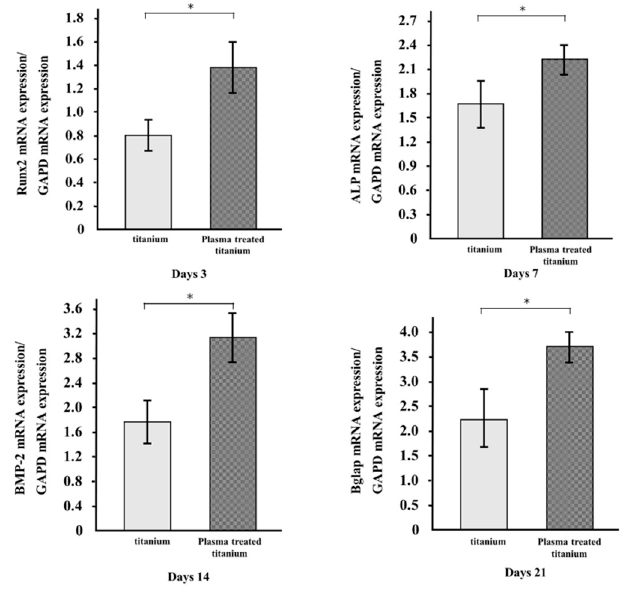
Figure 8. qRT-PCR analysis of titanium and plasma-modified titanium. All genes in the cells grown on plasma-treated titanium disk surfaces were upregulated compared to those in the cells on titanium disk.